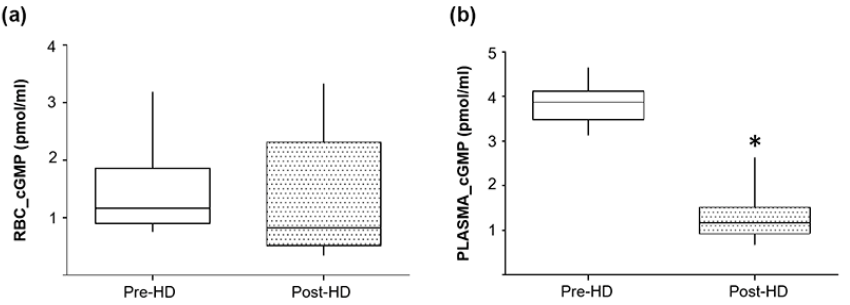
Figure 6. Pre- and post-hemodialysis cGMP levels in RBCs and plasma. Box plots representing ( a ) RBCs and ( b ) plasma cGMP levels in ESRD patients before and after hemodialysis (HD, × = 10). cGMP concentration was evaluated through ELISA and are expressed as picomoles/milliliters (pmol/mL). Horizontal black lines indicate the medians, boxes the interquartile range (IQR) and the bottom and top whiskers represent the minimum and maximum values. (* p < 0.05).